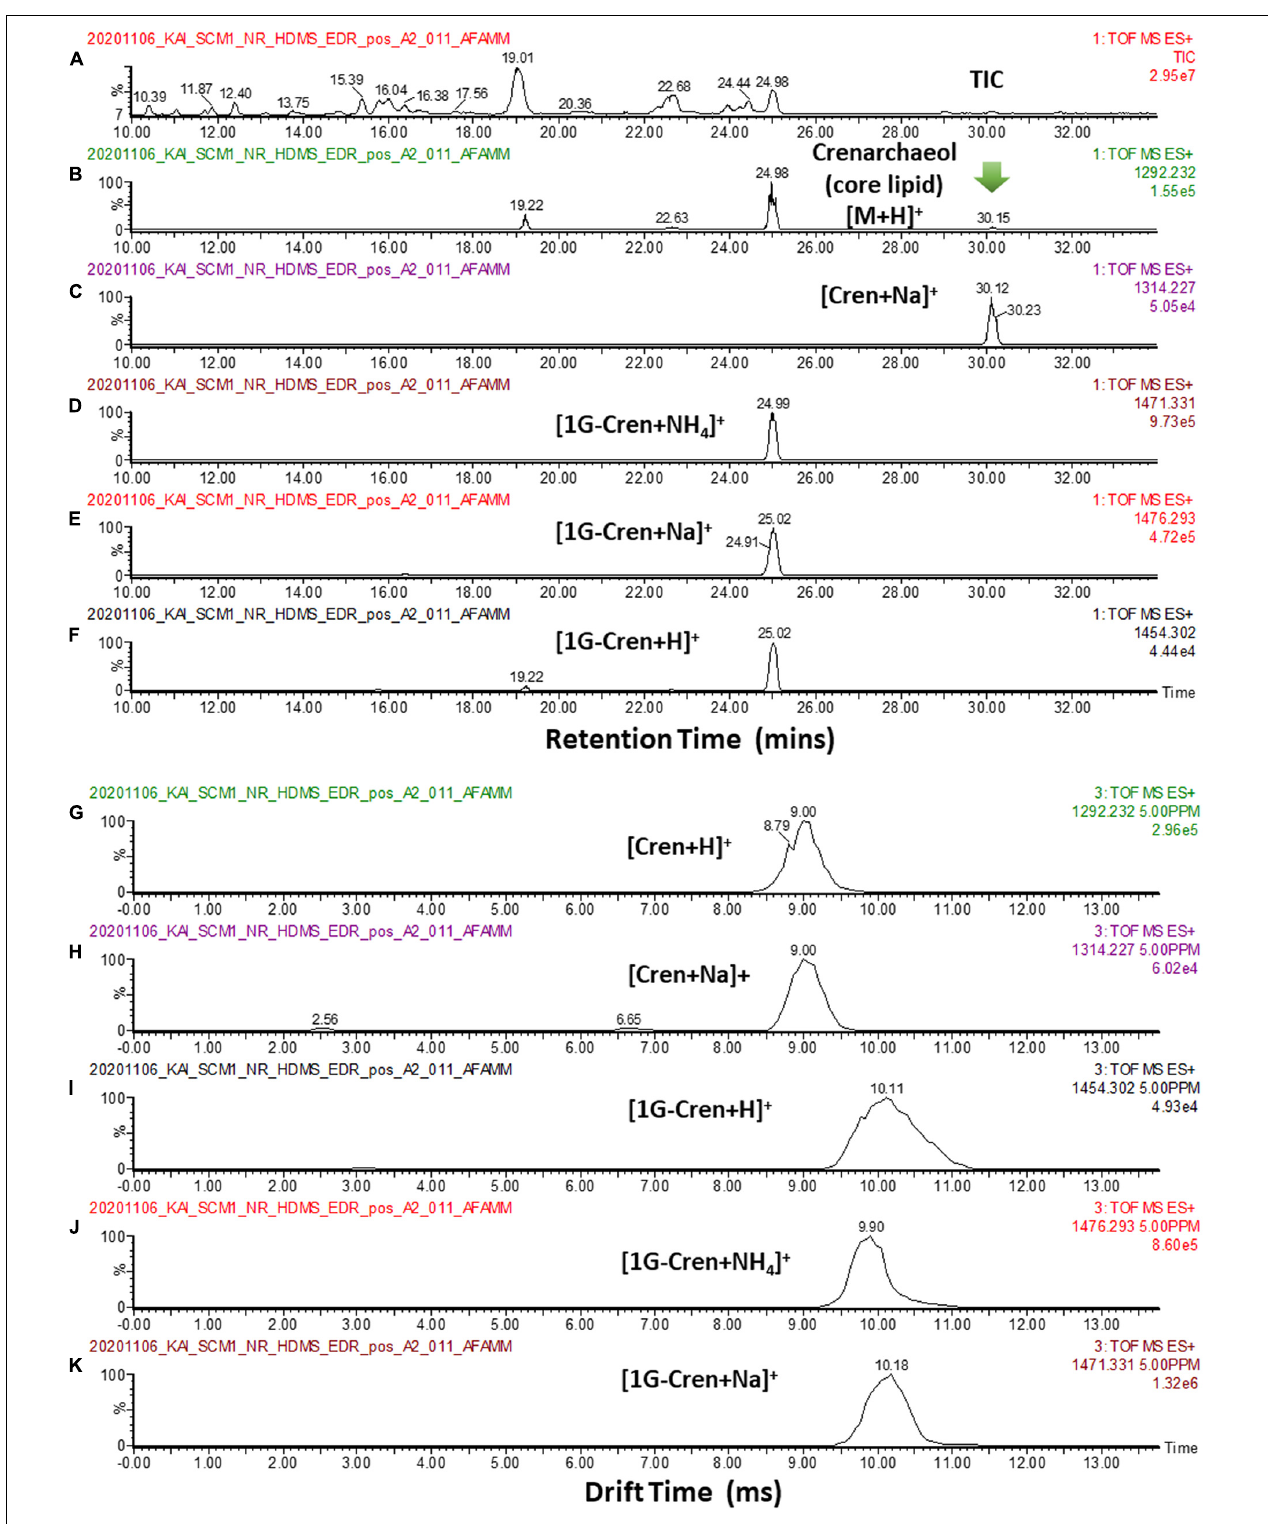
FIGURE 12 | (A) TIC of a typical cellular lipid extract of N. maritimus . (B,C) EIC of m/z 1292.232, and 1314.227 corresponding to the [M + H] + and [M + Na] + of core crenarchaeol ion eluted at 30.15 mins. Peaks eluted at 19.22 22.63 and 24.98 mins were fragment ions of diglycosidic and monoglycosidic crenarchaeols, with the same m/z of the core crenarchaeol ion. (D–F) EIC of m/z 1454.302, 1471.331, 1476.293 corresponding to the [M + H] + , [M + NH 4 ] + and [M + Na] + of monoglycosidic crenarchaeol. (G,H) Arrival time distributions of [M + H] + and [M + Na] + of core crenarchaeol. (I–K) Arrival time distributions of [M + H] + , [M + NH 4 ] + and [M + Na] + of monoglycosidic